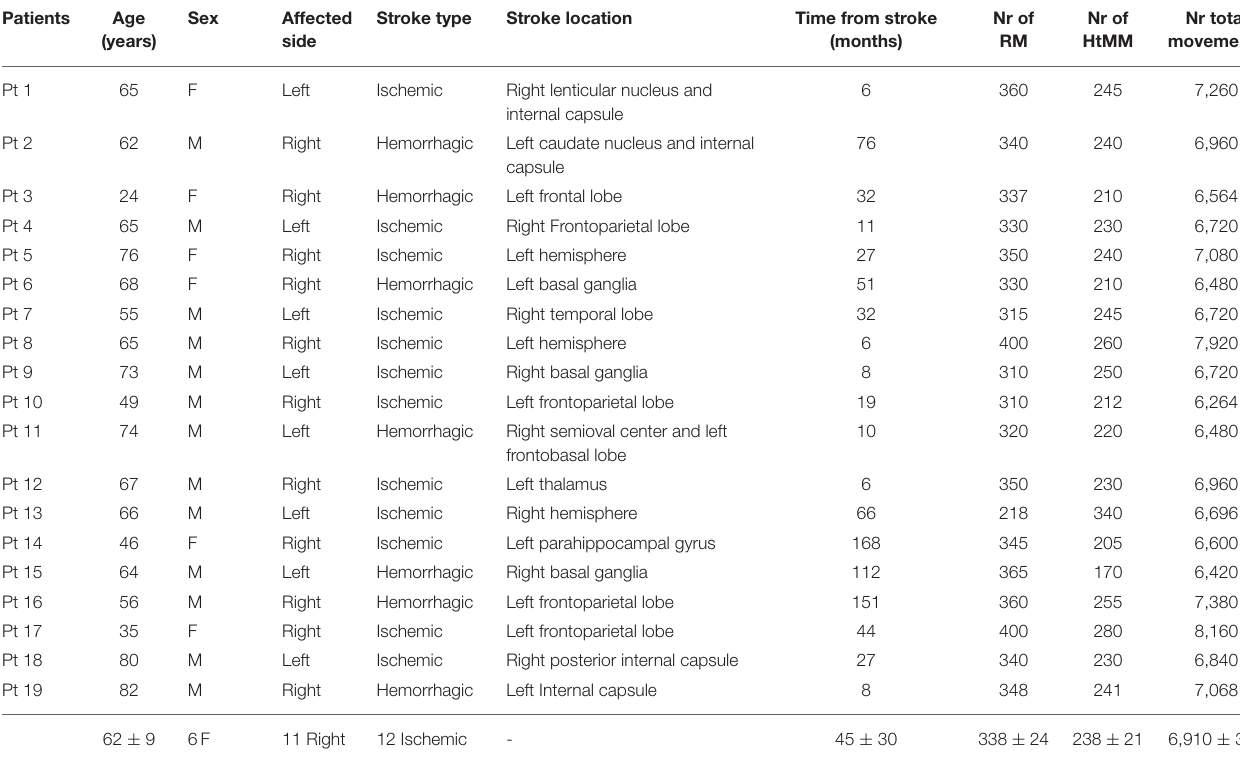
TABLE 1 | Patients’ data.